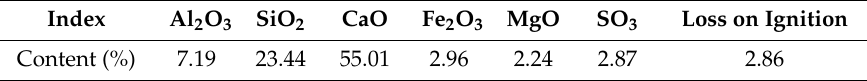
Table 2. Chemical composition of cement.